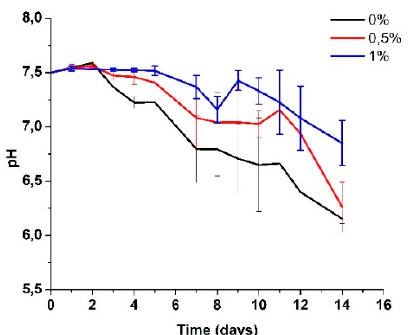
Figure 4. Change in pH in the SBF after several days of immersion of the electrospun CS/PVA/GO composite nanofibrous membranes with different GO amounts (0%, 0.5%, and 1.0%).